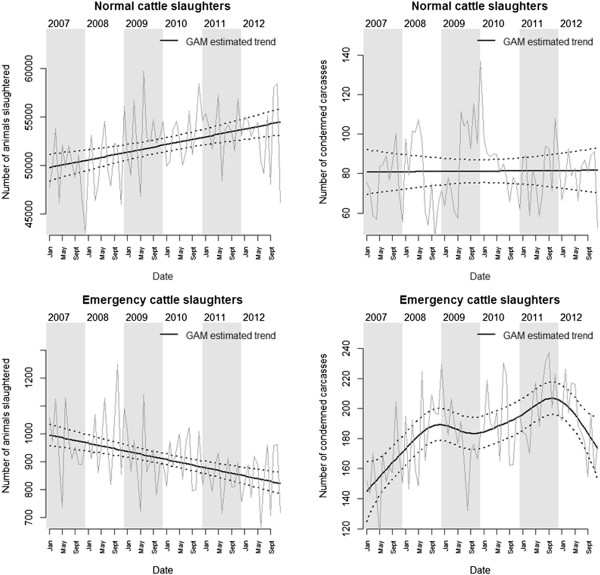
GAM estimated trends for the number of cattle carcasses. Monthly numbers of cattle slaughtered (left) and condemned carcasses (right) between 2007 and 2012 during normal slaughter (top) and emergency slaughter (bottom) are presented.